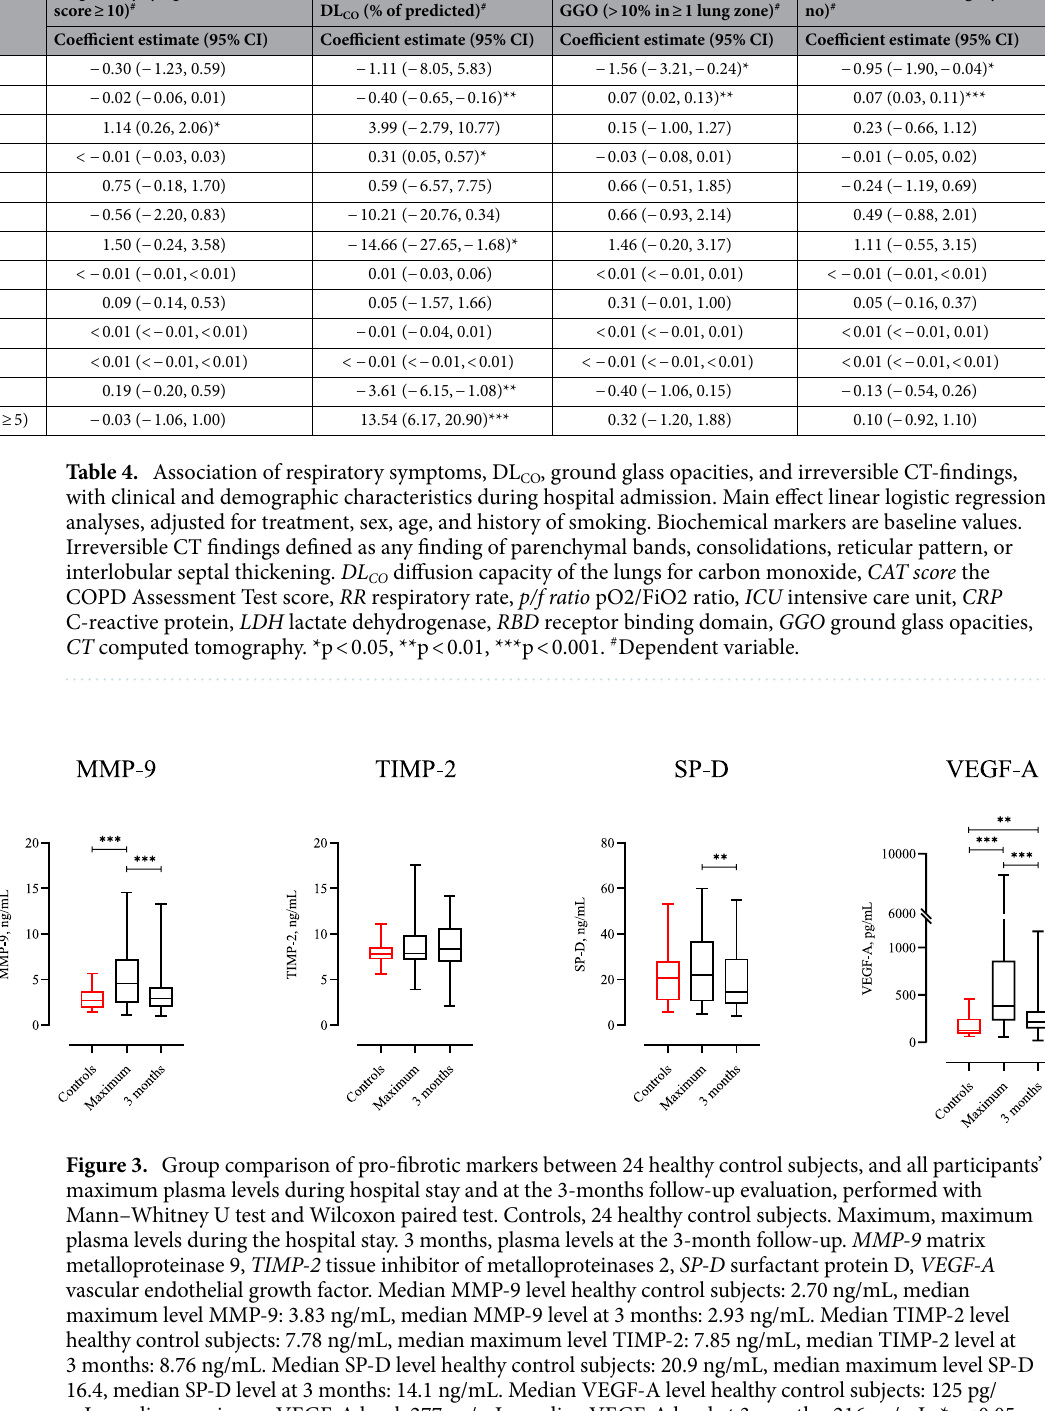
participants randomised to remdesivir and HCQ, and their respective SoC, with regard to pulmonary function and CT-findings, except for a somewhat higher symptom burden in the remdesivir group compared to the SoC group. Of the clinical characteristics during hospitalisation, a low P/F-ratio, the need for ICU admission, a high viral load, and low levels of IgG antibodies to SARS-CoV-2 seemed to predict reduced DL CO % at 3 months. Finally, high plasma levels of MMP-9, both during hospital stay and 3 months after hospitalisation, were associ- ated with signs of both reversible and irreversible changes on chest CT.